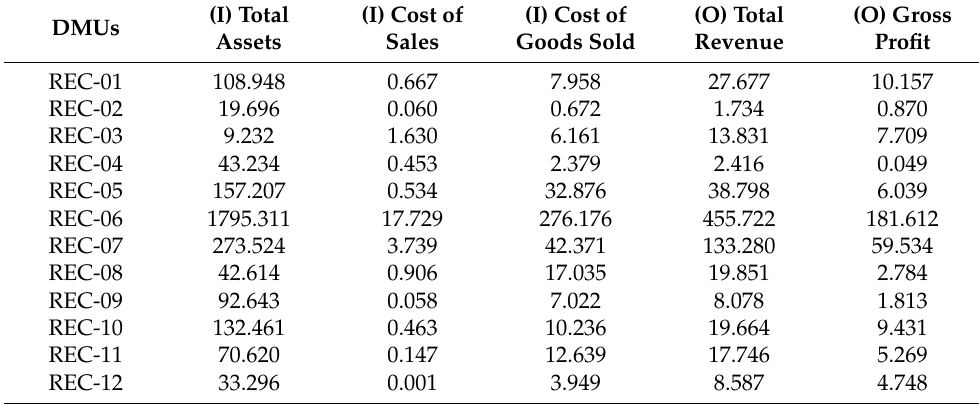
Table A5. The predictive data of the year 2019, (unit: million